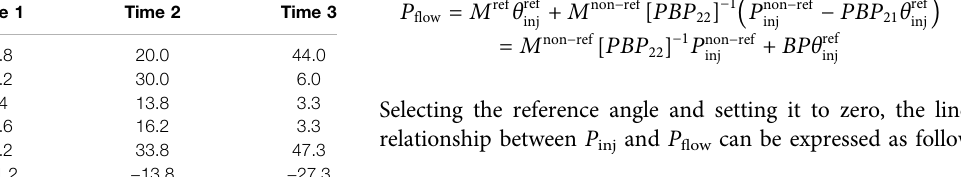
TABLE 6 | Capacity constraints of inter-provincial lines without considering security constraints. Clearing